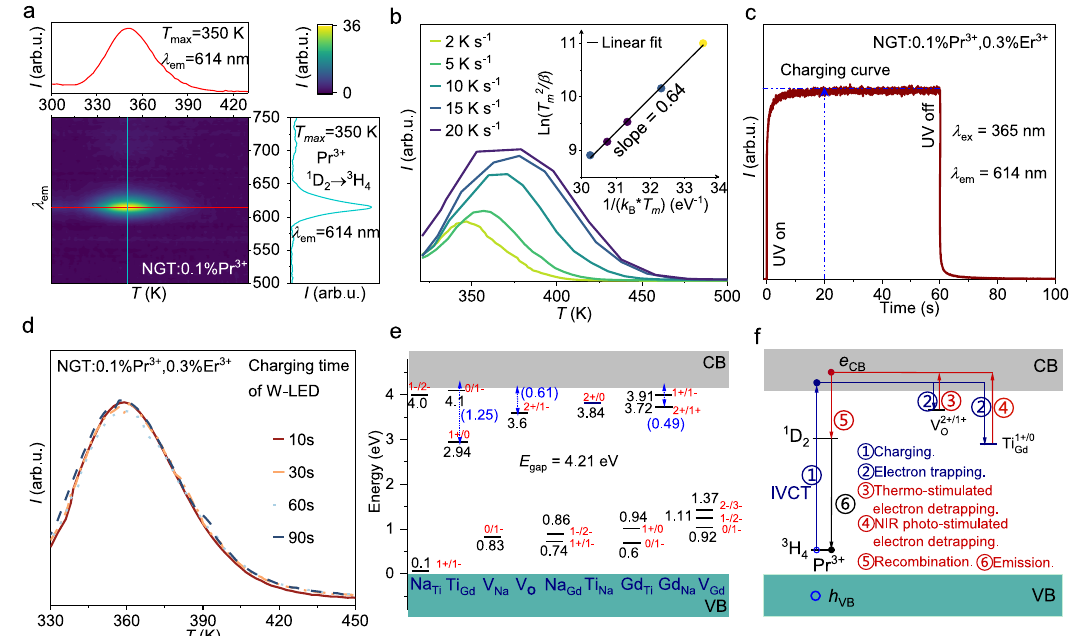
Fig. 3 | Interaction between defect levels and rare-earth emission centers in NGT.a ContourmappingoftheTLintensityafter365nmilluminationasafunction ofemissionwavelengthandtemperatureofNGT:0.1%Pr 3+ .Theheatingrateis2Ks − 1 . b TLglowcurvesofNGT:0.1%Pr 3+ atdifferentheatingrates β from2to20Ks − 1 .The sample was pre-irradiated by a 365nm UV lamp for 1min and decayed for 1min before eachmeasurement.Insetshowsthe fi ttingforthe determinationof thetrap depth using the Hoogenstraaten method. c Charging curve of NGT:0.1%Pr 3+ , 0.3% Er 3+ with excitation wavelength λ ex =365nm. d TL glow curves of NGT:0.1%Pr 3+ ,